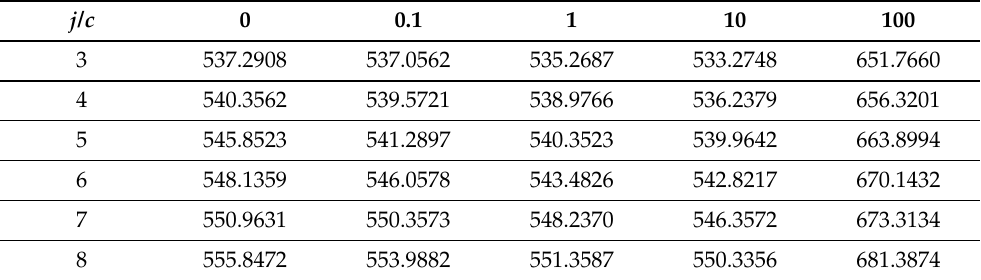
Table 3. Condition numbers of the stiffness matrix B j